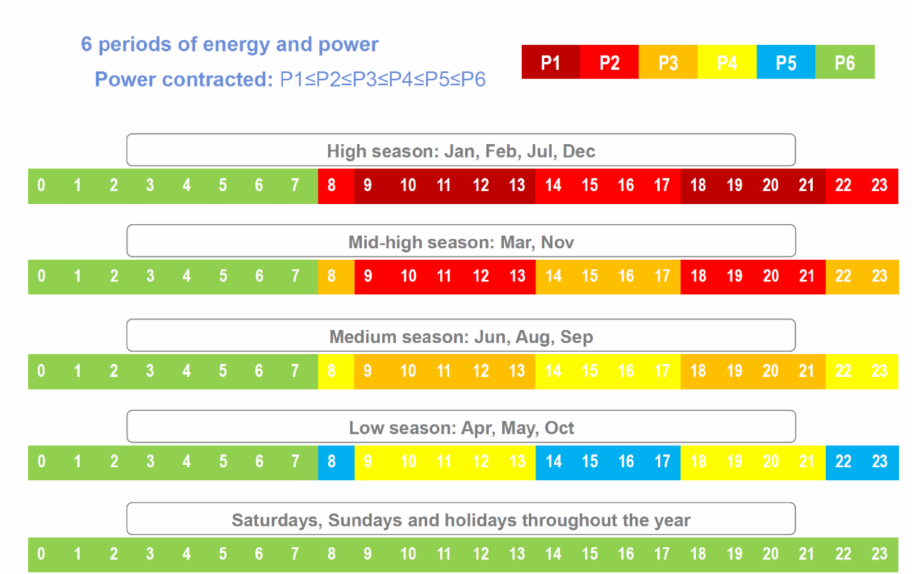
Figure 1. Time-discriminating 6-period tariffs in mainland